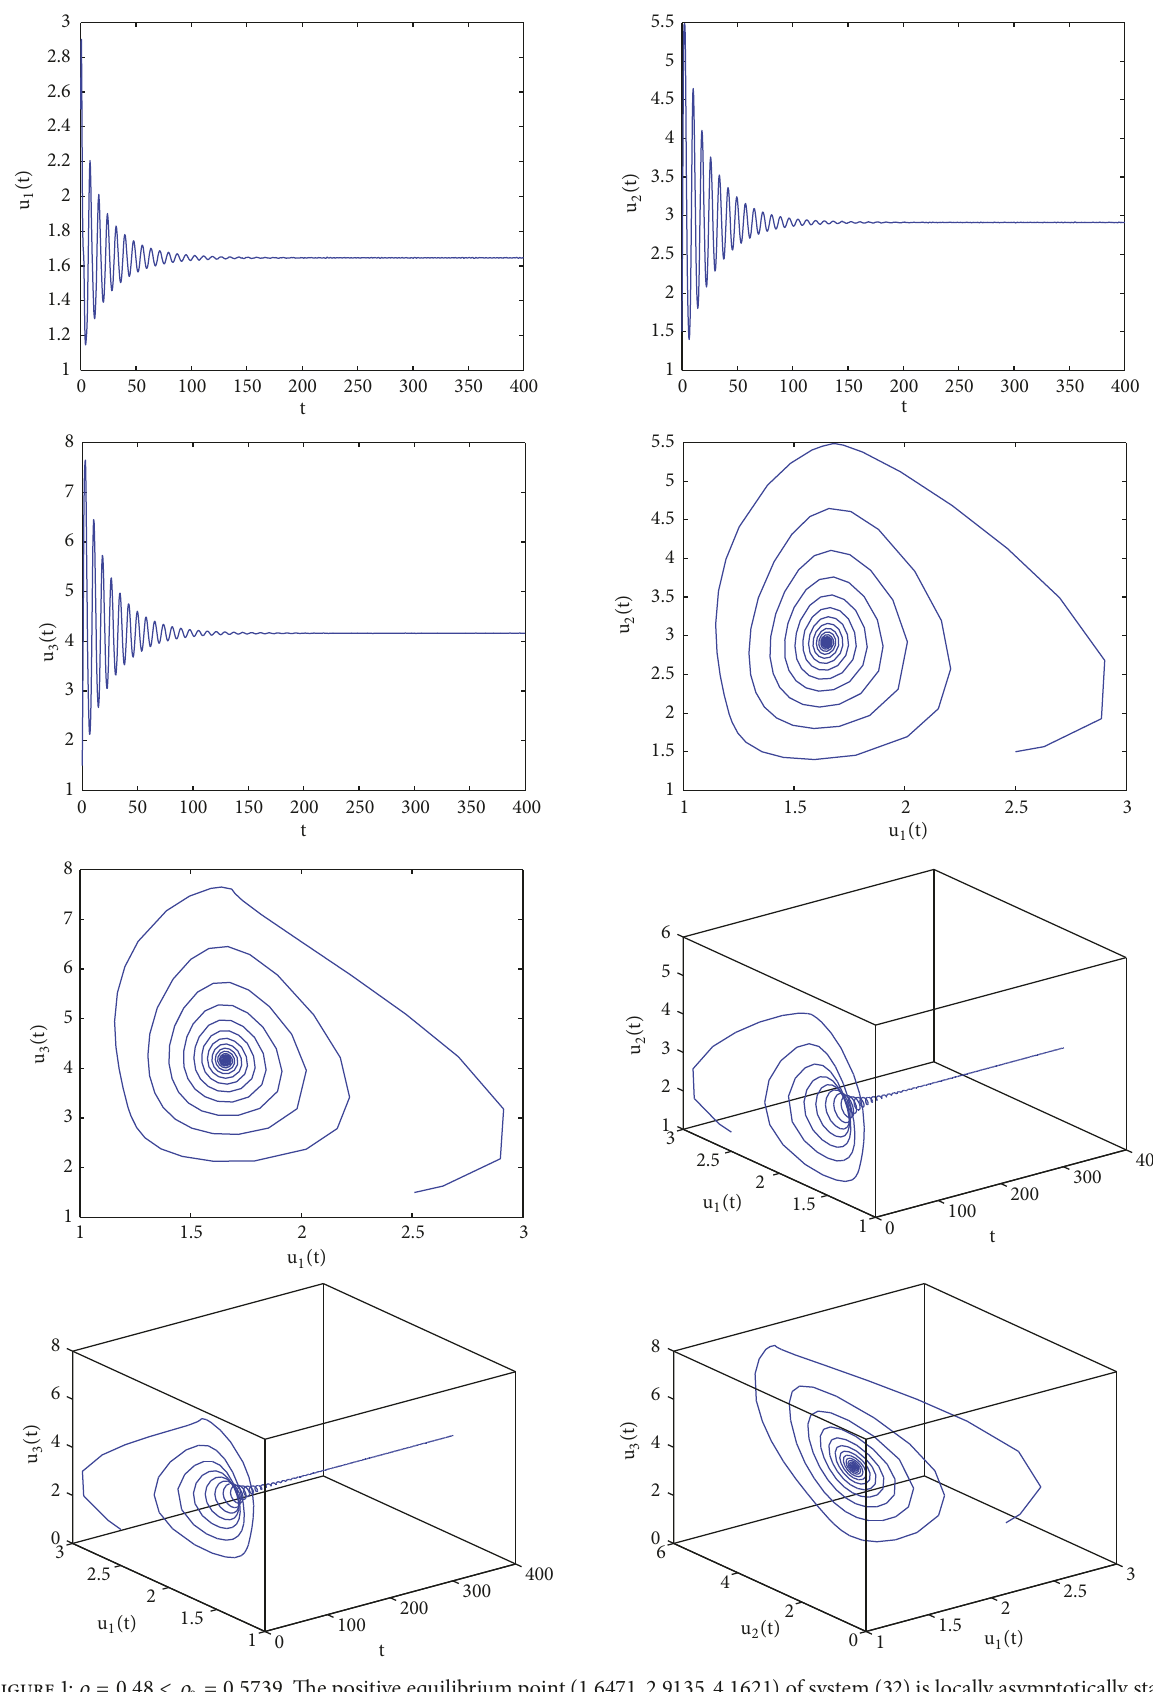
Figure 1: 𝜌 = 0.48 < 𝜌 0 = 0.5739. The positive equilibrium point (1.6471,2.9135,4.1621) of system (32) is locally asymptotically